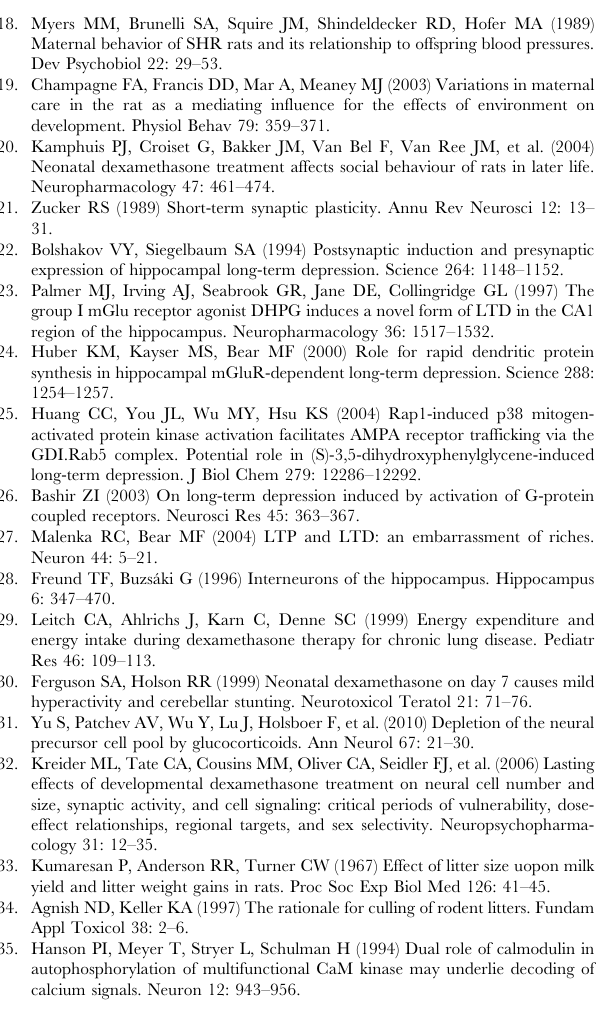
B. The total number of animals examined is indicated by n in parenthesis. Figure S3 Effect of neonatal DEX treatment on the number of parvalbumin (PA)-immunoreactive interneurons in the hippocam- pal CA1 region. (A) Representative photomicrographs with PV- immunostaining of CA1 region showing that the expression of PV- immunoreactive interneurons was not altered by neonatal DEX treatment in rats from Group A and Group B. (B) Group data showing the summary results from 6 rats of each group at 5 weeks old. The parvalbumin-immunoreactive cells in hippocampal CA1 region were classified into two distinct subpopulations: multi-polar round cells with a long axis: short axis ratio , 1.5 and larger spindle-shaped cells with a long axis: short axis ratio . or = 1.5.(n = 4 for each group). Figure S4 Effect of neonatal DEX treatment on GABAA receptor-mediated inhibition of hippocampal CA1 pyramidal neurons. (A) Stimulus-response curve of IPSC amplitude versus stimulus intensity in the CA1 region of hippocampal slices from 5- week-old rats of Group A that received neonatal SAL or DEX treatment. Inset shows overlaid traces (each an average of 3 responses) evoked in a slice from a SAL- (left set of traces)